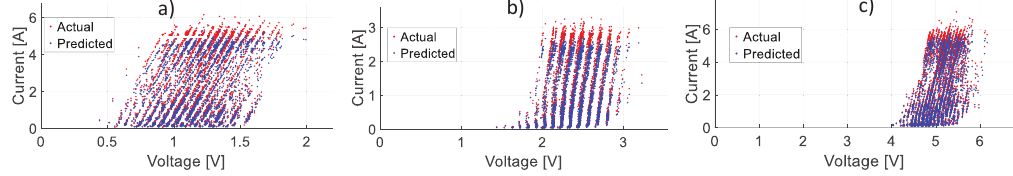
Figure 10. The actual and simulated points of: ( a ) Cocoa xSi12922 PV panel, ( b ) Cocoa mSi0166 PV panel, ( c ) Cocoa HIT05667 PV